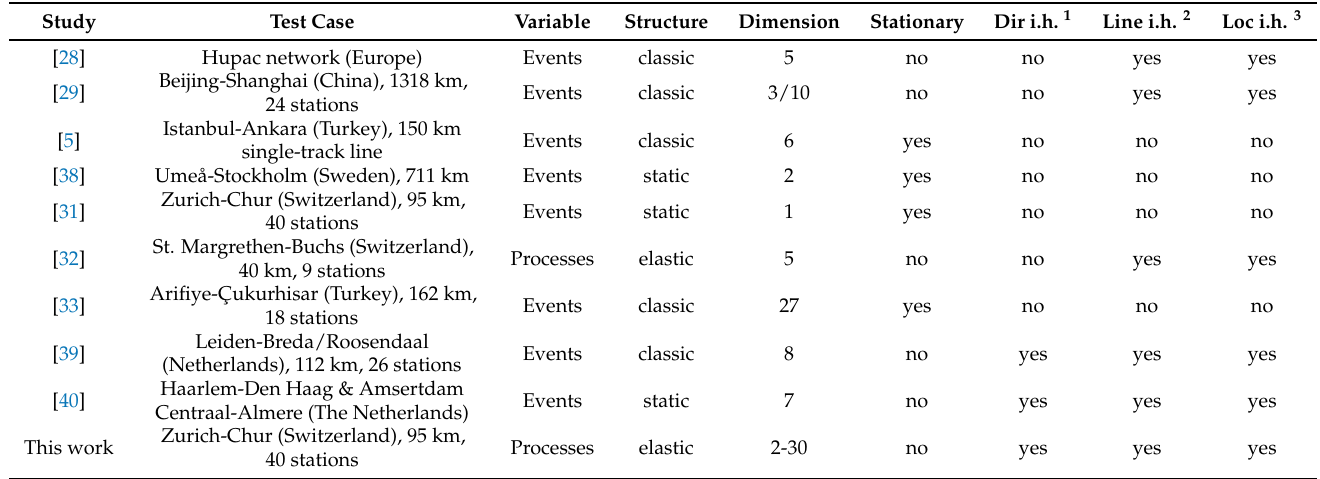
Table 1. Specifications and assumptions of Markov chain model-based contributions in the context of train delay